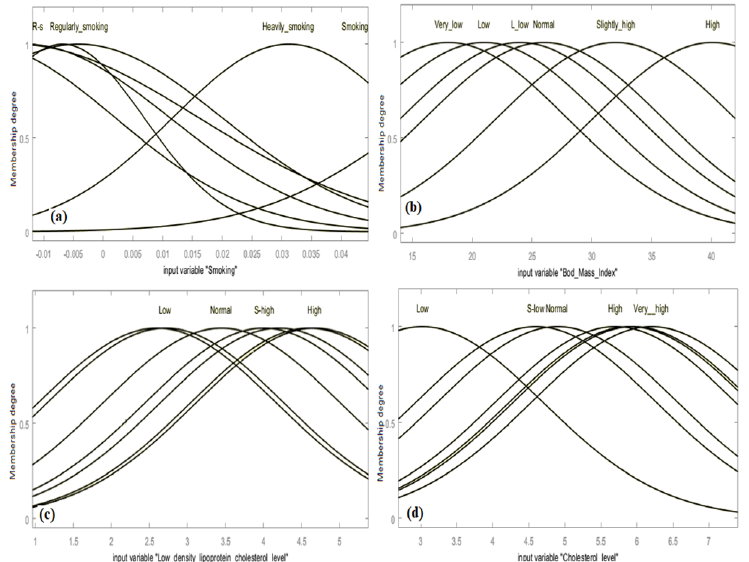
Figure 11. MFs for ANFIS model obtained for the estimation of CVDs; see abbreviations in Nomen-